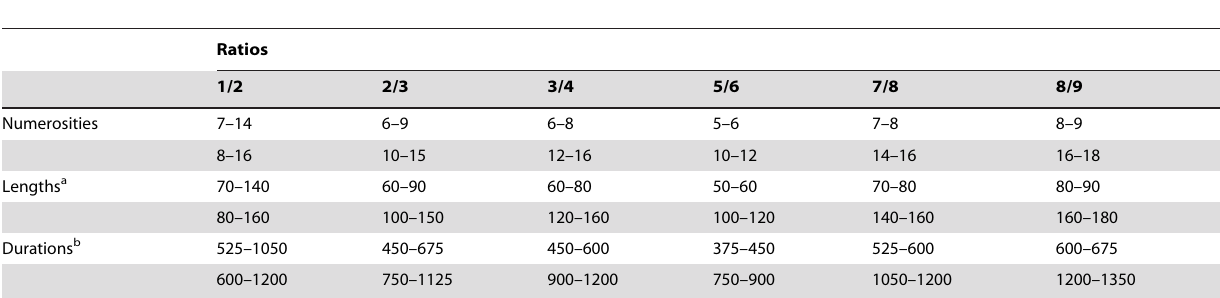
Table 1. Pairs of Magnitudes Presented in the Numerical and Non-Numerical Comparison Tasks.